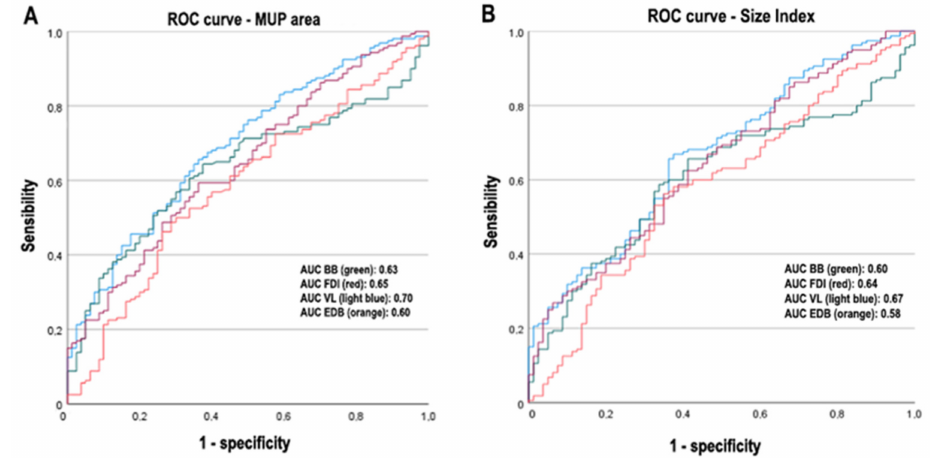
Figure 4. ROC curves for MUP area and size index (CIDP patients vs. HCs). Figure legend: BB: brachial biceps; FDI: first dorsal interosseous; VL: vastus lateralis; EDB: extensor digitorum brevis; MUP: motor unit potential; AUC: area under the